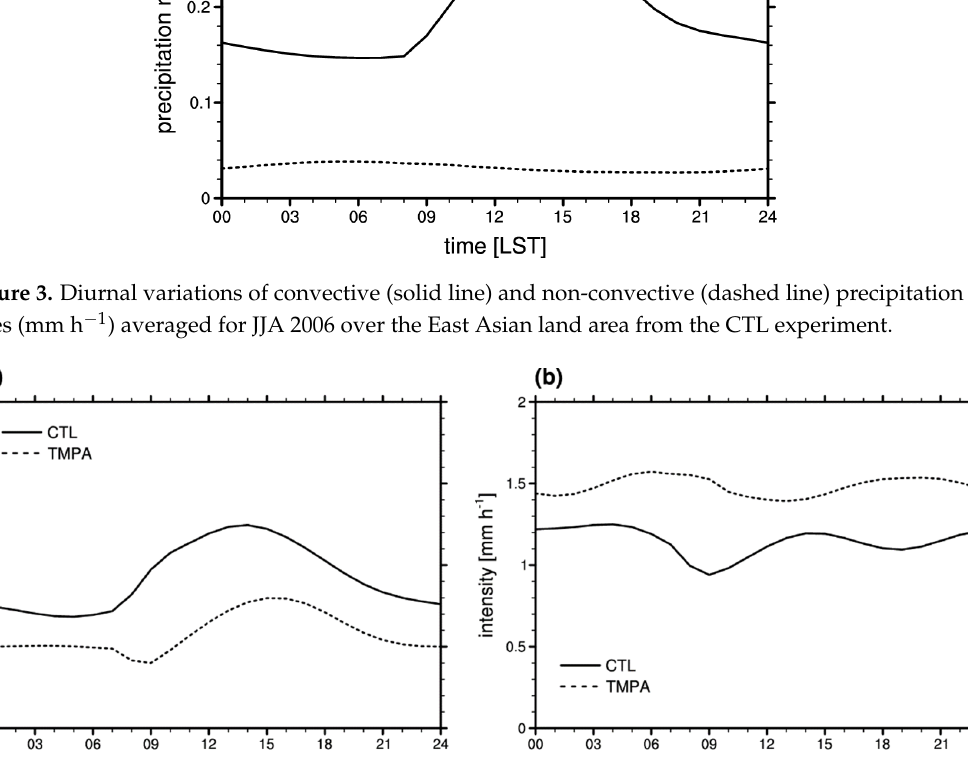
Figure 4. Diurnal variations of ( a ) precipitation frequency (%) and ( b ) precipitation intensity per precipitation occurrence (mm h − 1 ) averaged for JJA 2006 over the East Asian land area from the TMPA observation (dashed lines) and CTL experiment (solid lines).